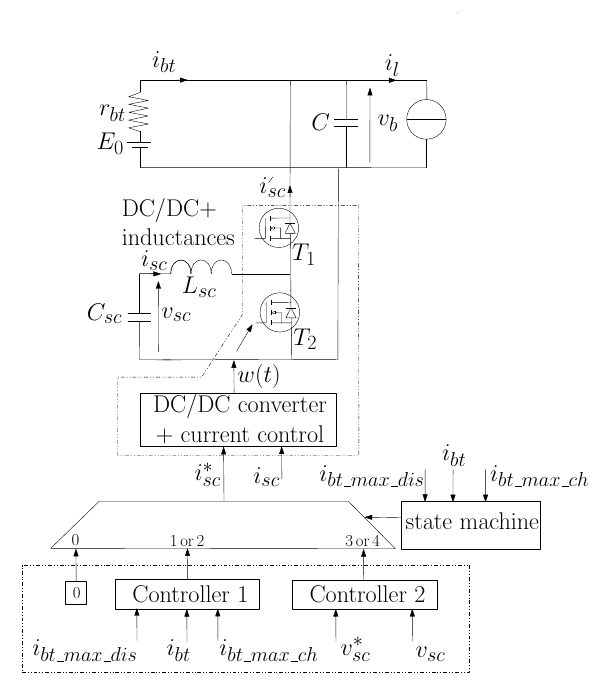
Figure 5. Controllers of the charge depleting mode with SoC recovering of the SCs.